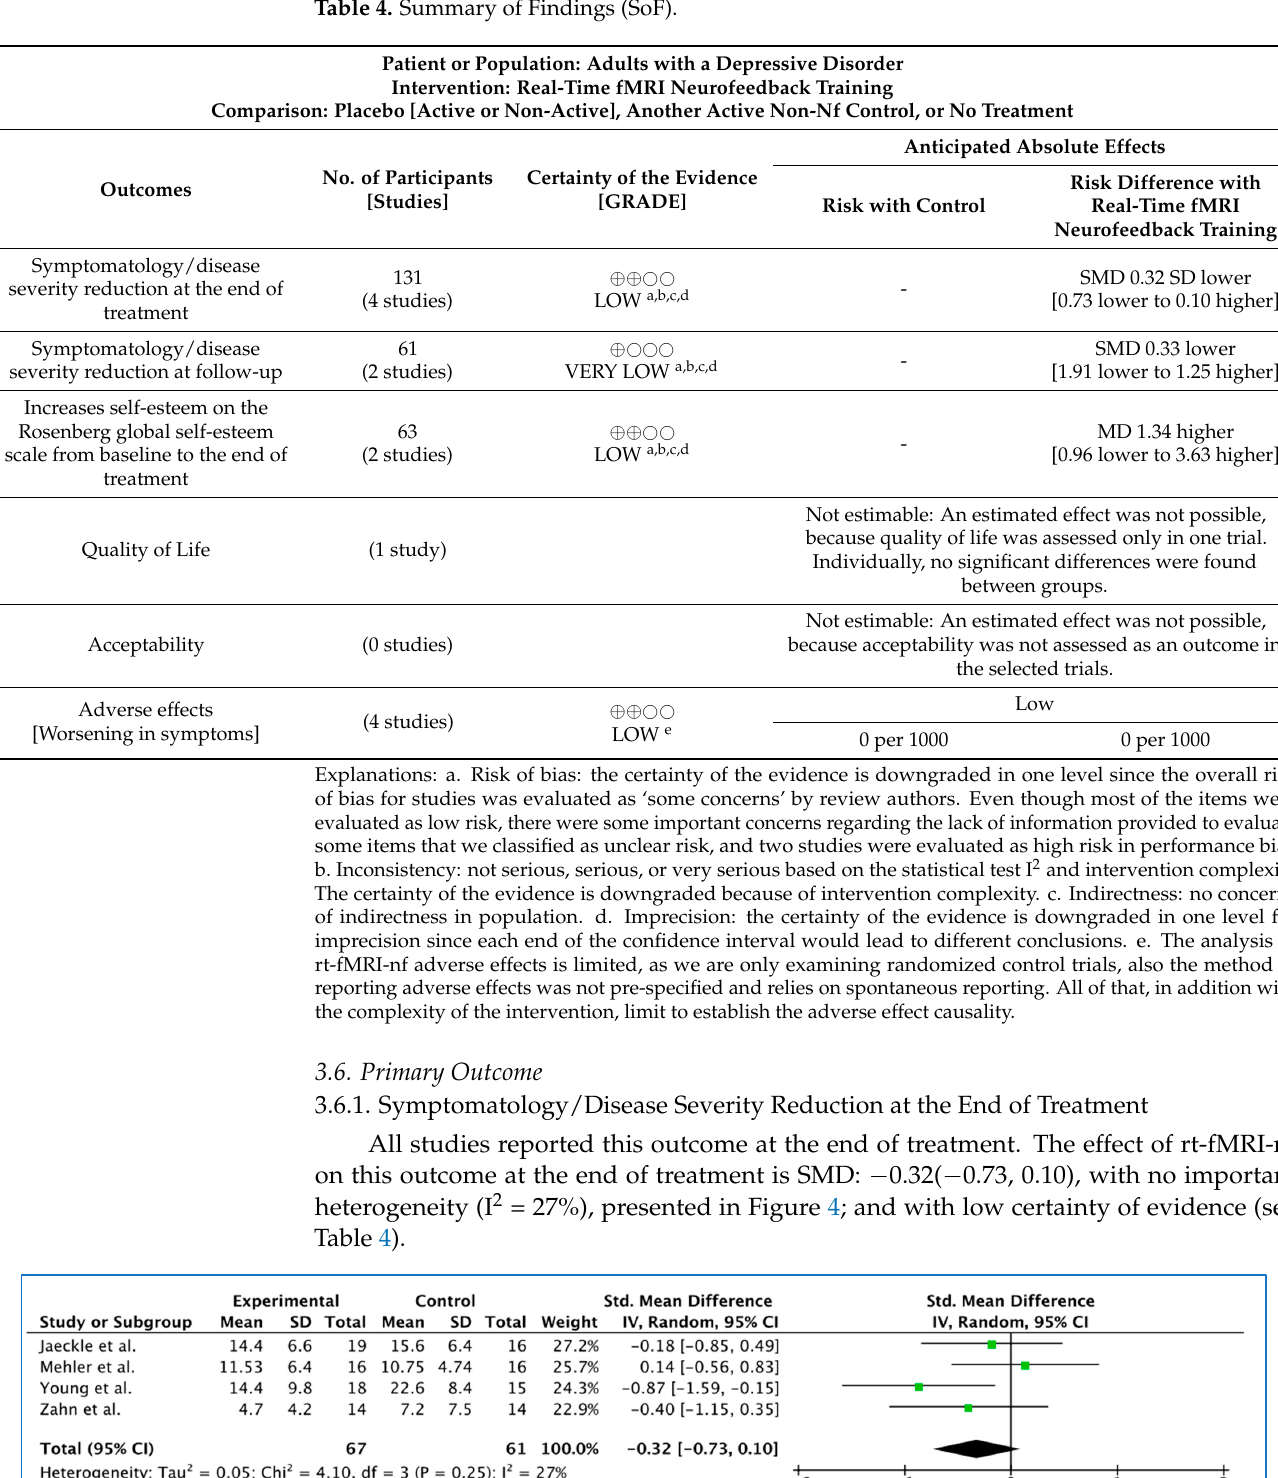
Table 4. Summary of Findings (SoF).